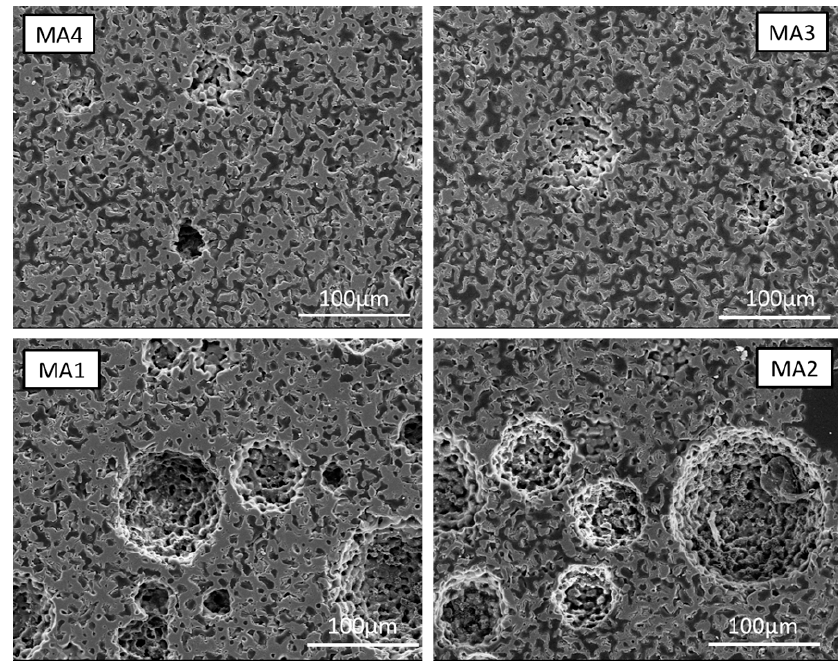
Figure 7. Sintered samples produced with 10–40 wt% PMMA.